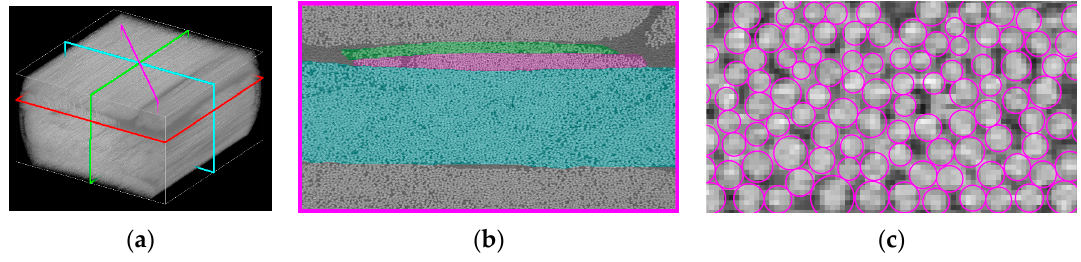
Figure 4. Segmentation of 0°, magenta: 45°, and green: 90° bundles, where the 0° is in the loading direction. ( a ) Cut planes, ( b ) Bundle segmentation, ( c ) Fibre segmentation.